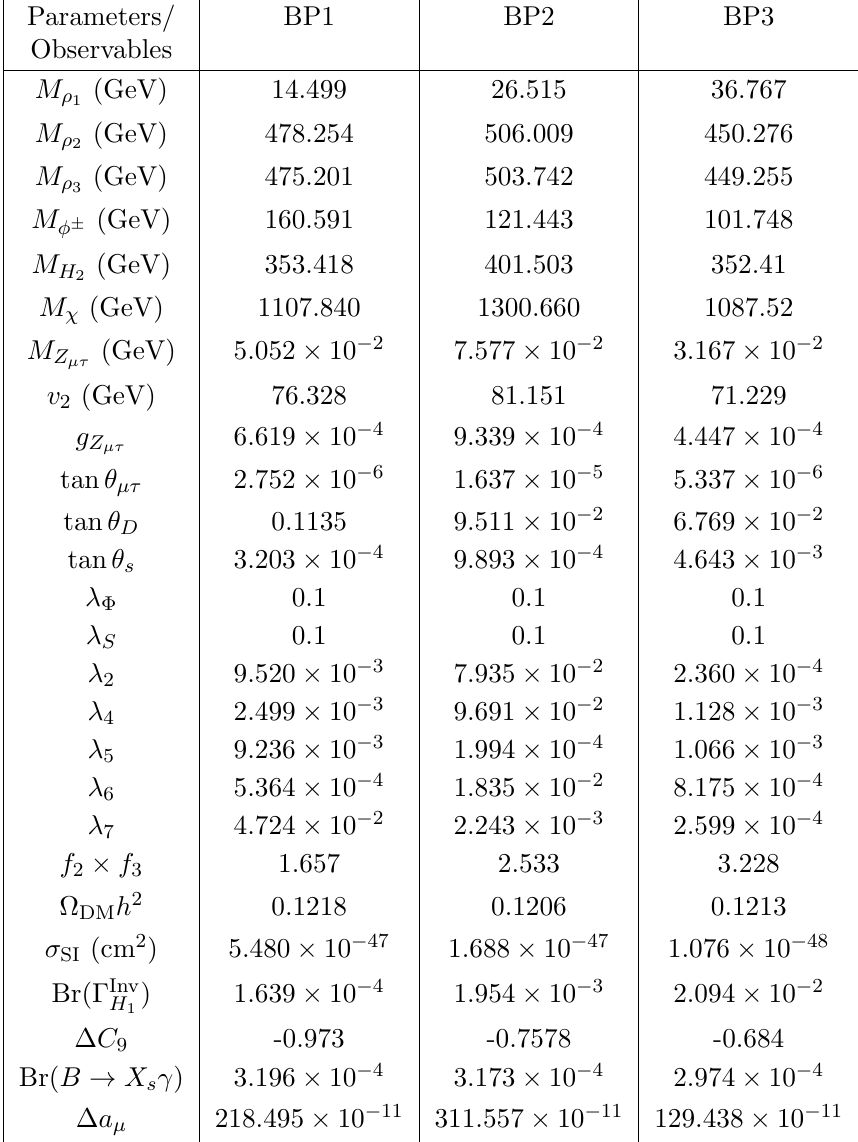
Table 3 . Viable benchmark points (BP1, BP2 and BP3) and corresponding numerical values of several physical quantities of the present